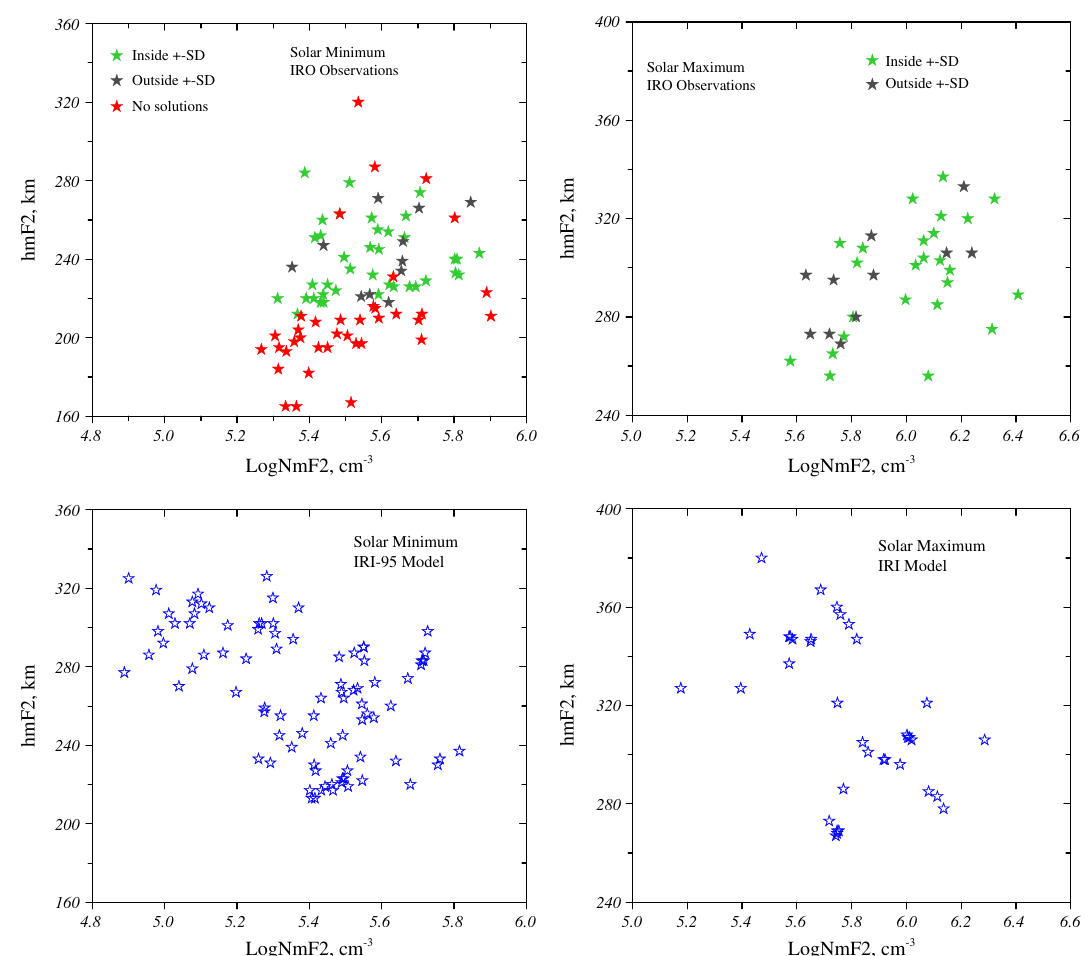
Fig. 8. Scatterplots of hmF2 vs. LogNmF2 for all the analyzed IRO observations in a comparison with the climatological IRI-95 model for solar minimum and solar maximum